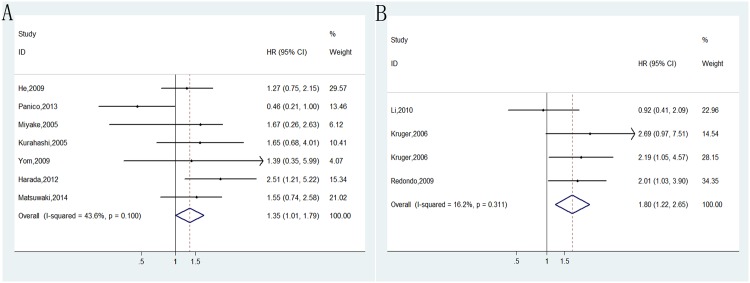
Forest plots of merged analyses of disease-free survival (DFS)/relapse-free survival (RFS) in association with sCLU expression in different groups.Forest plots of merged analyses of overall survival (OS). Squares and horizontal lines represent study-specific HRs and 95% CIs, respectively. The areas of the squares correspond to weights, and the diamonds represent overall HRs and 95% CIs. (A) Forest plots of merged analyses of RFS/DFS in group 1. (B) Forest plots of merged analyses of RFS/DFS in group3.